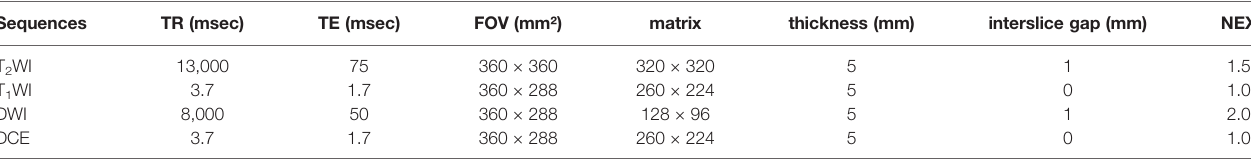
TABLE 1 | Imaging protocol parameters for multi-parametric MRI.